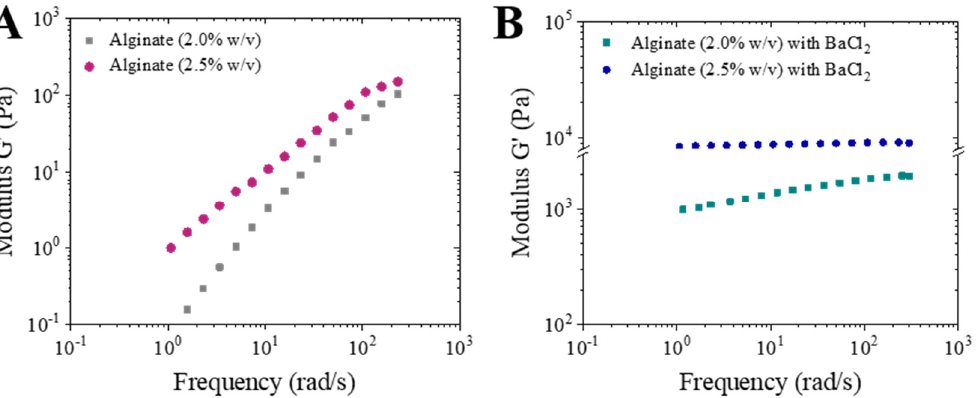
Figure 1. Rheological analysis of: ( A ) Alginate solutions (2% and 2.5% w / v ); ( B ) Alginate gels (2% and 2.5% w / v ) with BaCl2 (2% w / v ) as crosslinker.